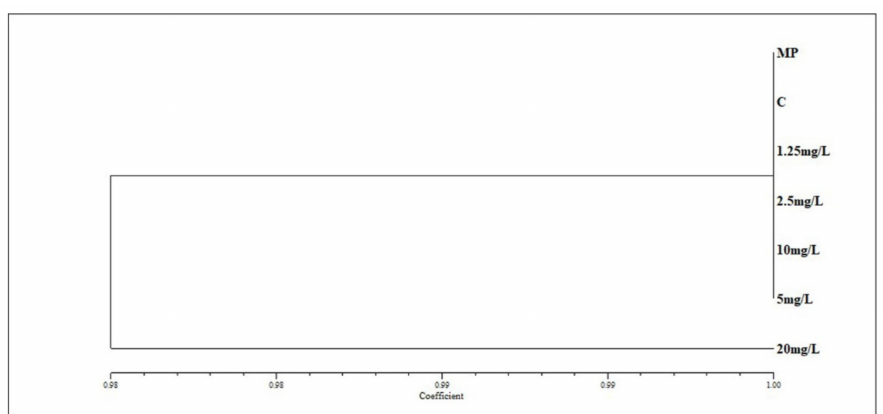
Figure 9. Dendrogram based on UPGMA analysis presenting the relationships between M. oblongifolia shoots plants treated with ZnO NPs (C, 1.25, 1.5, 5, 10 and 20 mg/L); MP = Mother plant.